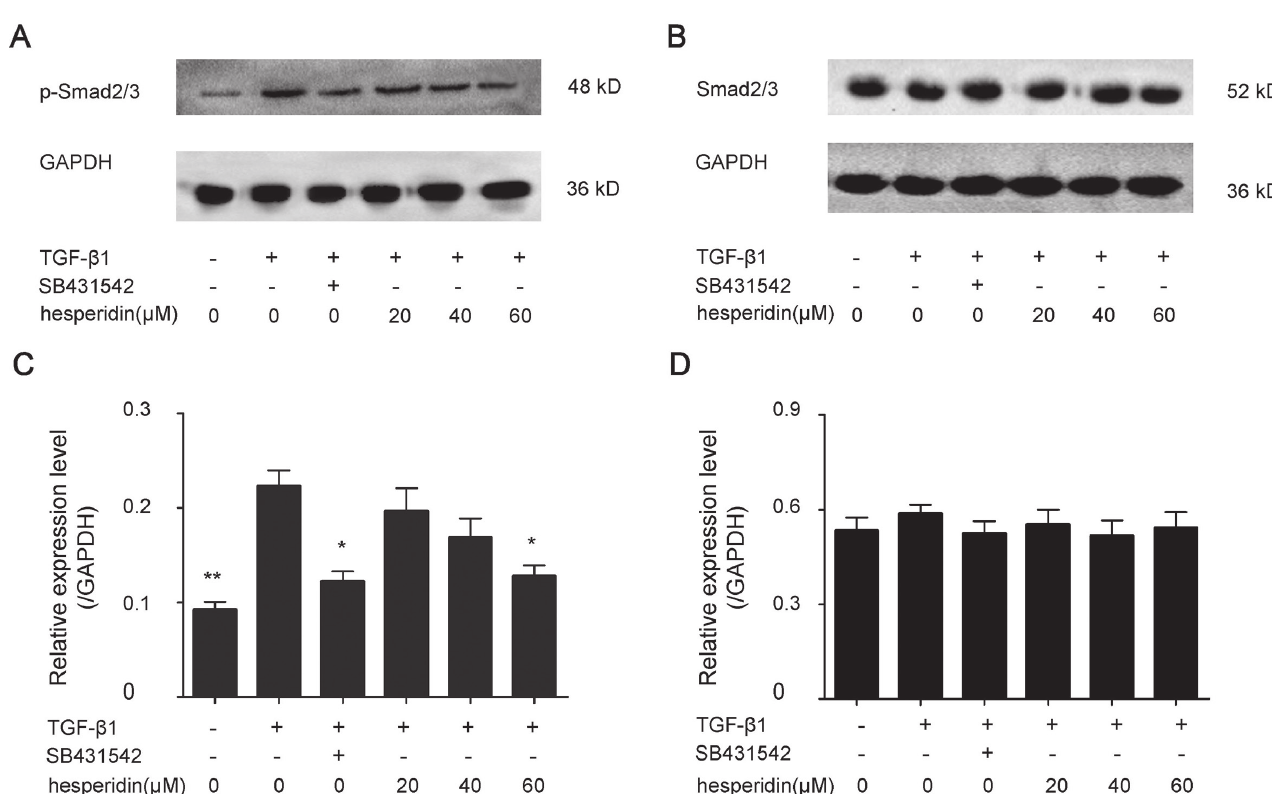
FIGURE 4 - Effect of hesperidin on Smad 2/3 phosphorylation in the cytoplasm. Lanes 1, 2, 3, 4, 5 and 6 represent the normal control, TGF-β1 control, SB431542+TGF-β1, 20 μM heperidin+TGF-β1, 40 μM heperidin+TGF-β1 and 60 μM heperidin+TGF-β1 groups, respectively. The GADPH expression was the loading control. The quantitative data, expressing the corresponding Smad proteins level, were assessed using densitometry and are expressed in relative intensity arbitrary units in the panels. The bar represents the standard error of the mean (n = 5). *p < 0.05 and **p < 0.01 compared to the TGF-β1control group.